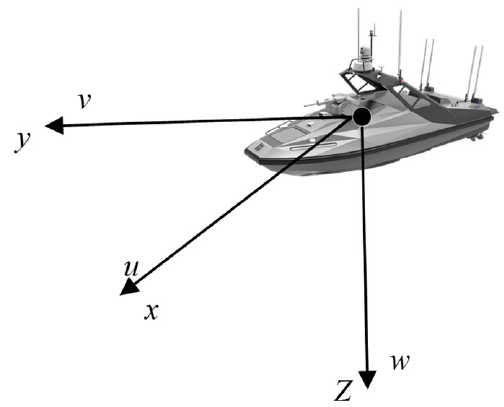
Figure 2. The illustration of UUV.